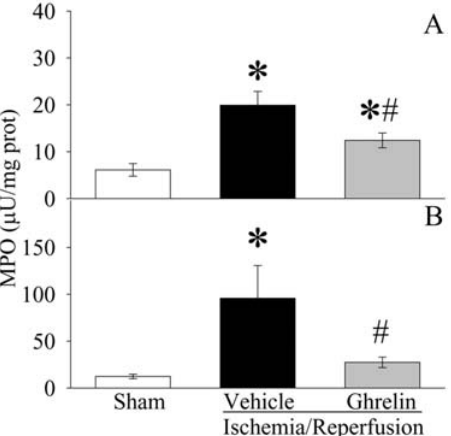
Figure 3. Alterations in intestinal (A) and pulmonary (B) MPO activities in sham-operated animals (Sham) and ischemia/ reperfusion animals treated with normal saline (Vehicle) or ghrelin (Ghrelin) at 1.5 h after the completion of treatment (i.e., 2 h after reperfusion). Data are presented as means 6 SE (n=5– 6) and compared by one-way ANOVA and Student-Newman-Keuls test: * P , 0.05 versus Sham group; # P , 0.05 versus Vehicle group.